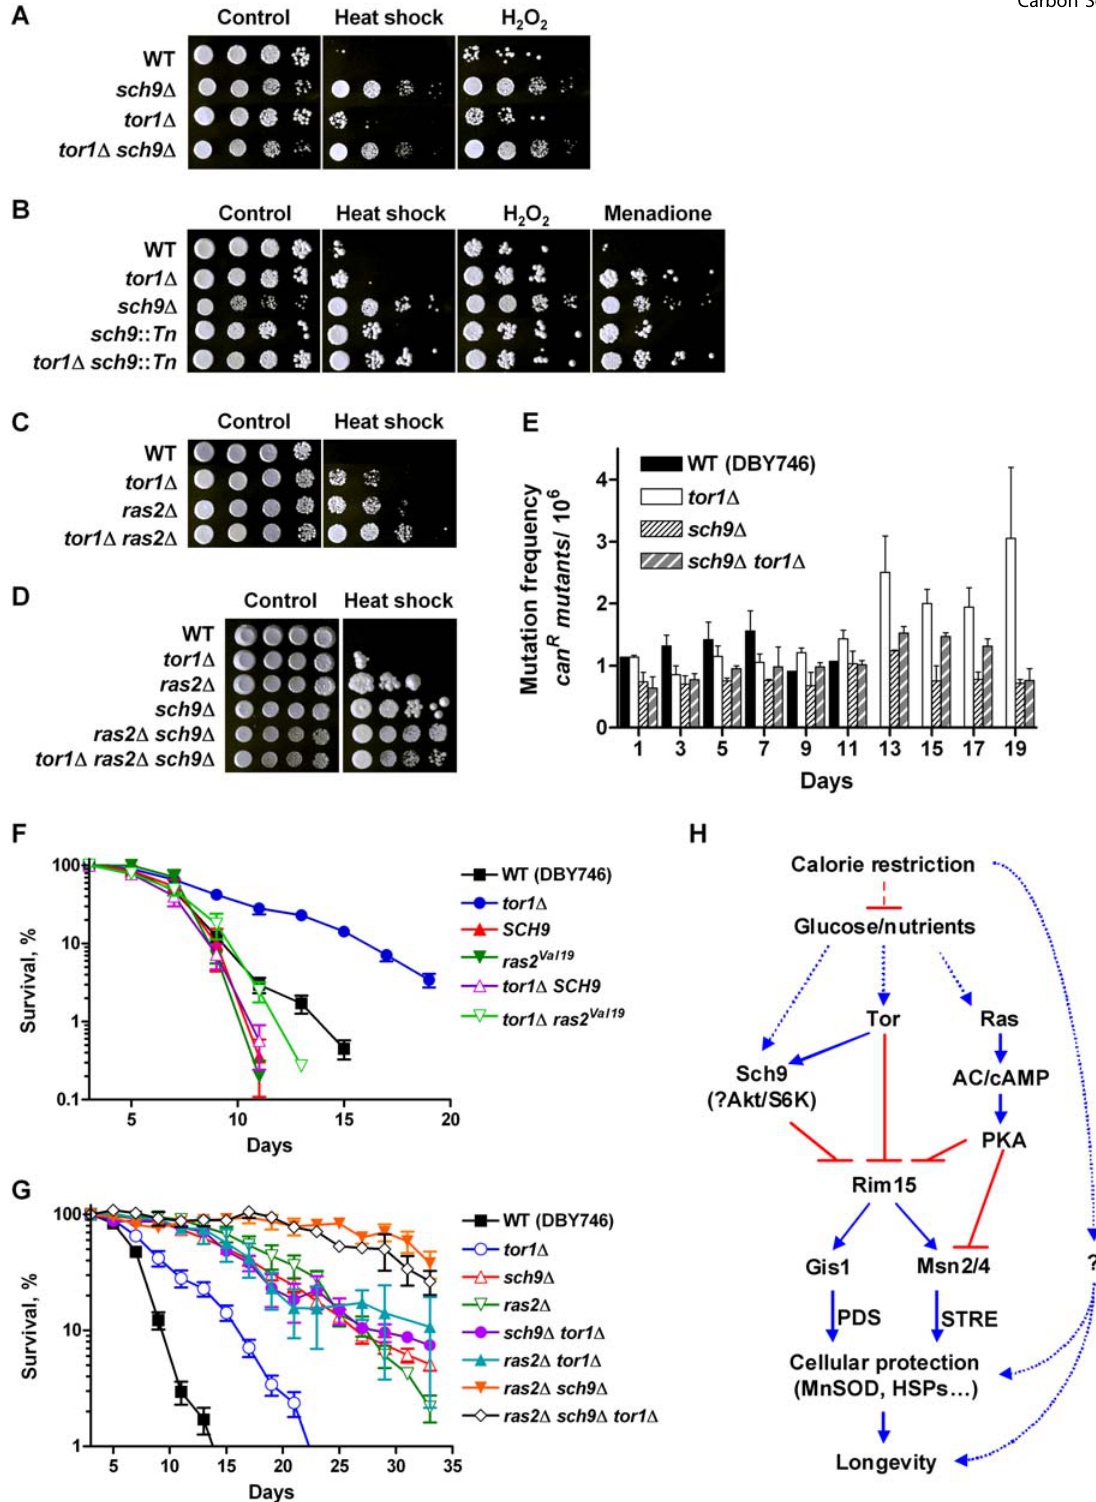
Figure 1. Genetic interactions between Sch9, Tor1, and Ras2 in regulating stress resistance and life span. (A–D) Day 3 wild type (DBY746) and cells lacking Tor1, Sch9, or Ras2 were challenged with heat shock (55 u C: A, 105 min; B, 75 min; C, 150 min; and D, 120 min) or oxidative stresses (H 2 O 2 , 100 mM for 60 min; or menadione, 250 m M for 30 min). (E) Mutation frequency over time measured as Can r mutants per million cells. The average of four experiments is shown. Error bars represent SEM. (F) Chronological survival in minimal complete medium (SDC) of wild type, tor1 D , and mutants overexpressing either SCH9 or constitutively active Ras2 ( ras2 Val19 ). (G) Chronological survival of wild type and mutants lacking Tor1, Sch9, Ras2 or combinations. The data represent average of at least 4 experiments. Error bars show SEM. For mean life span calculated from non-linear curve fitting see Table S1. (H) Longevity regulatory pathways in yeast. The nutrient sensing pathways controlled by Sch9, Tor, and Ras converge on the protein kinase Rim15. In turn, the stress response transcription factors Msn2, Msn4, and Gis1 transactivate stress response genes and enhance cellular protection, which lead to life span extension. Pro-longevity effects of CR are partially mediated by Sch9, Tor, and Ras, and may also require additional yet-to-be indentified mechanism(s).